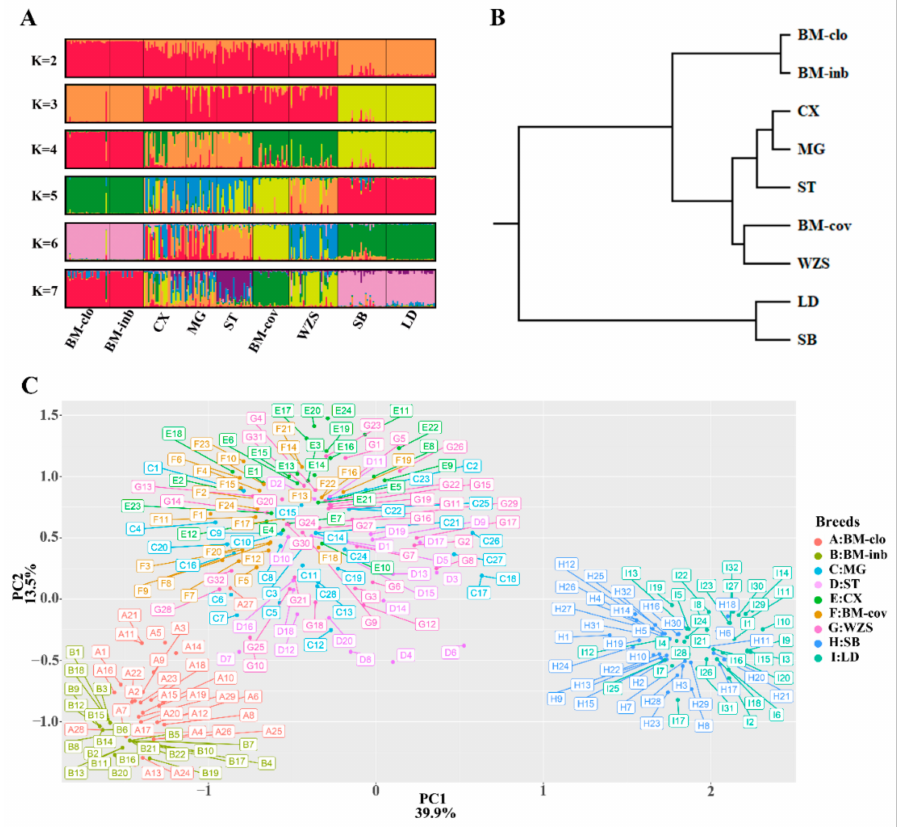
Figure 4. Population structure of seven Chinese miniature pigs and Sicilian black pigs. ( A ) Graphical representation of the results generated by Structure software with K 2–7. ( B ) UPGMA tree on Nei’s genetic distances. ( C ) PCA plot for eight pig populations; distribution along the first two